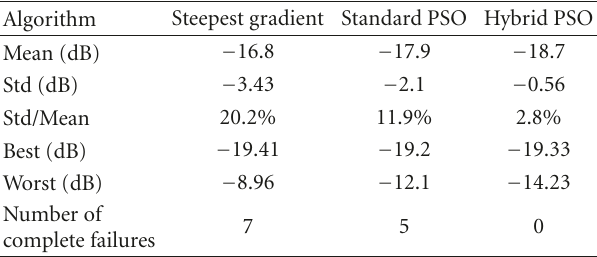
Table 1: Standard deviation of NMSE of channel impulse response estimations for three methods (SNR = 10, T =